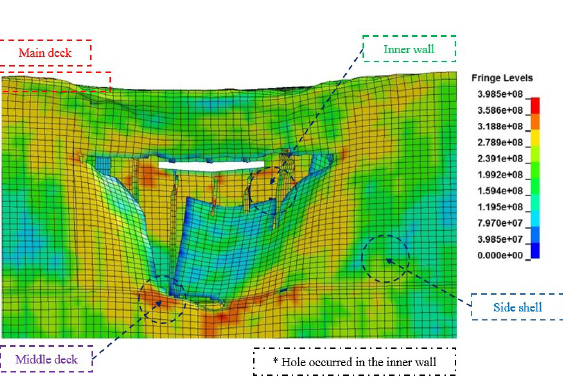
verified that carbon composition is the most suitable indi- cator in assessing material strength. The highest strength material contains highest carbon composition which after